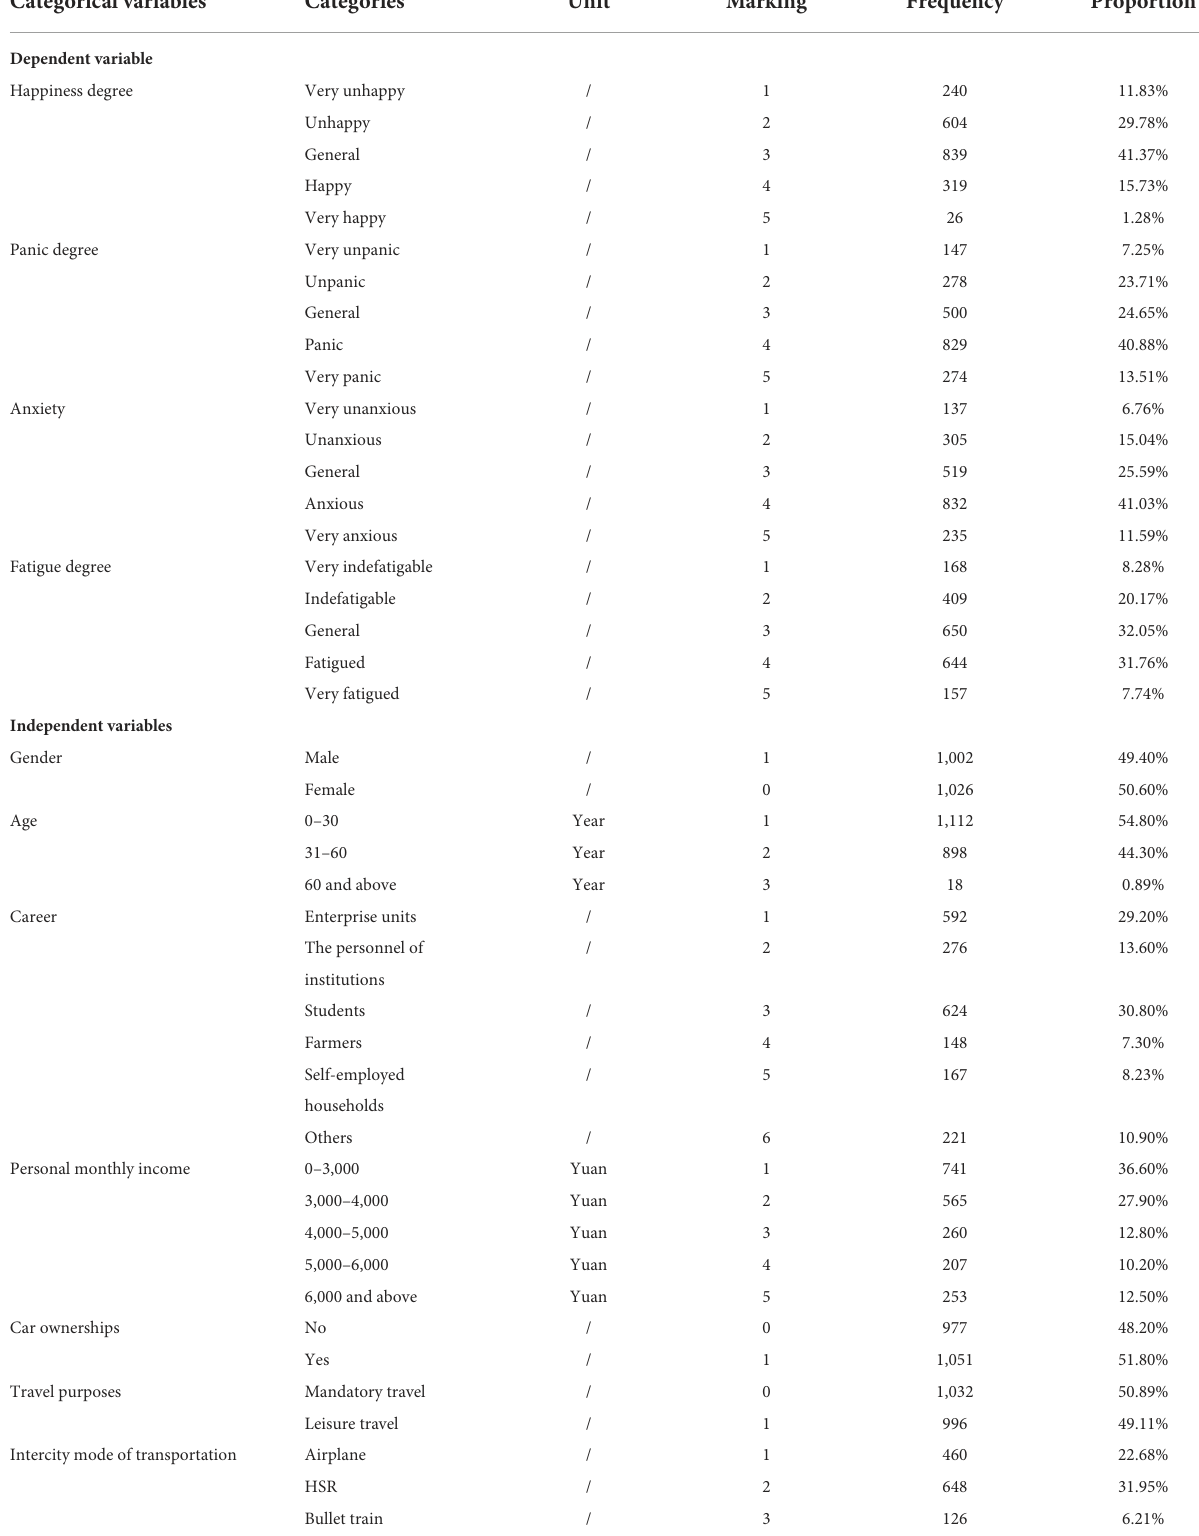
TABLE 4 Description of the category